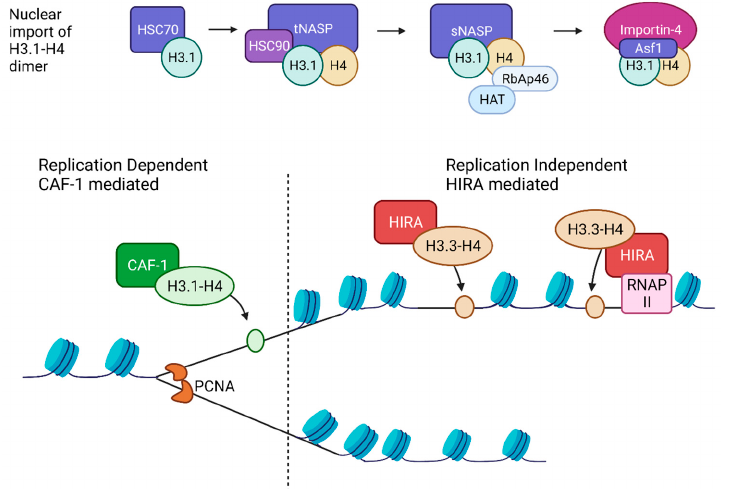
Figure 1. Nuclear import and deposition of newly synthesized H3-H4 molecules by histone chaperones into nucleosomes. Newly synthesized H3.1 associates with different chaperones in the process of nuclear import. The H3.1-H4 dimer is then assembled into a nucleosome in a replication-dependent method by its chaperone CAF-1, which is being recruited by proliferating cell nuclear antigen (PCNA) at replicating DNA. Newly synthesized H3.3-H4 is deposited onto DNA by the HIRA